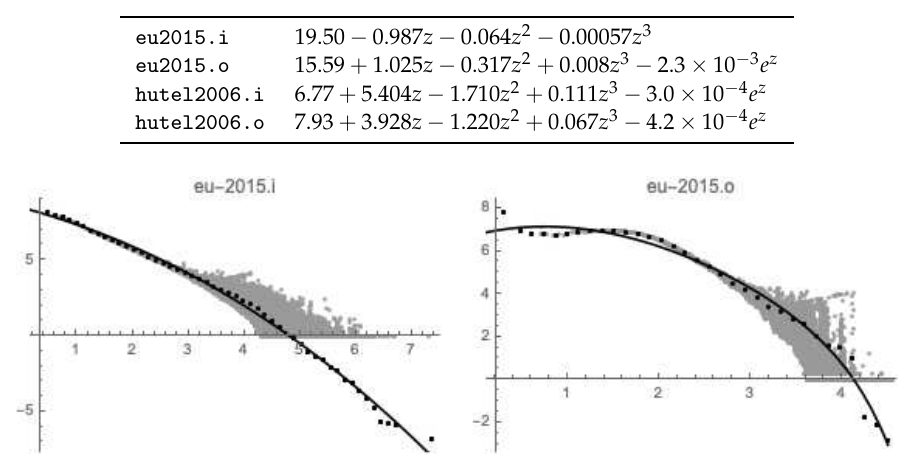
Table 4. Solutions of four selected directed graphs.